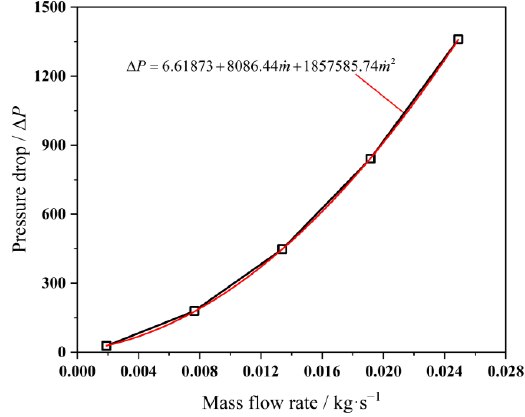
Figure 8. The variation in pressure drop with mass flow rate.